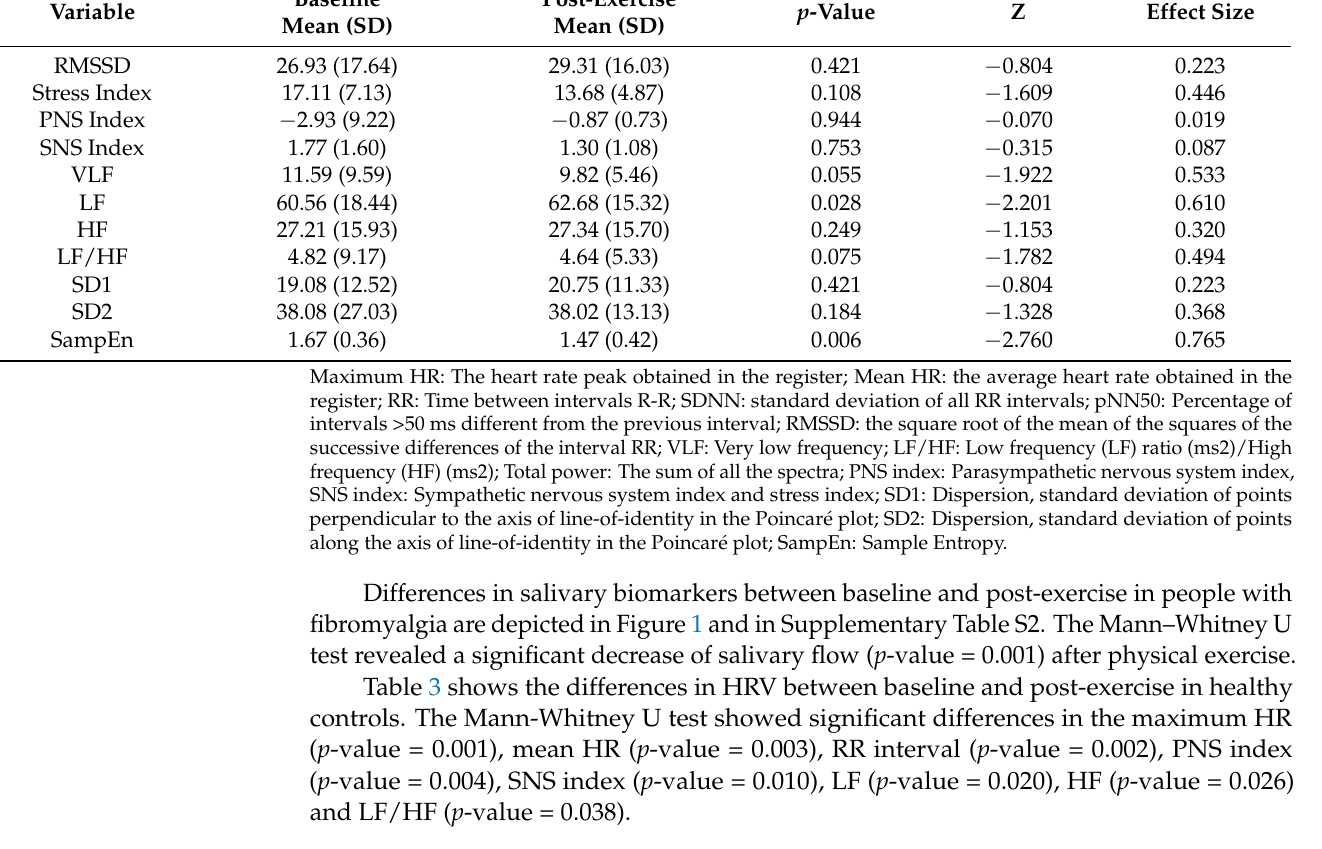
Table 3. HRV at baseline and after exercise in healthy